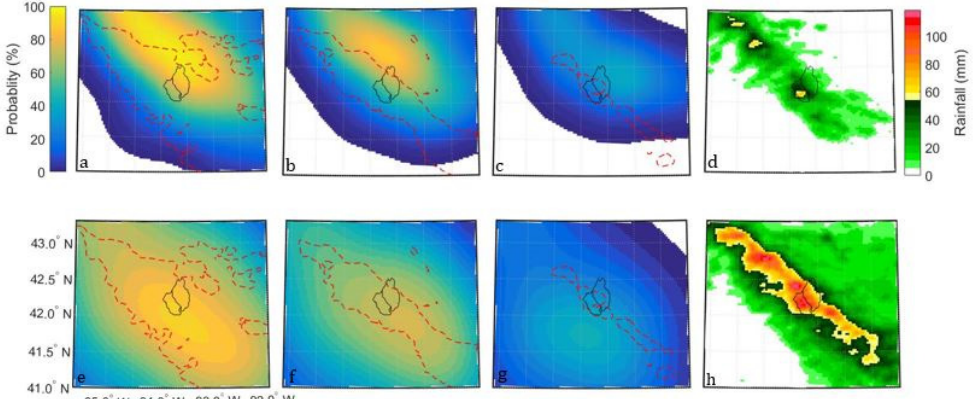
Figure 6. PQPF for the period 12–18 UTC on 14 June from the HRRRE ( a – c ) and HREF ( e – g ) initialized at 00 UTC 14 June, and Stage IV rainfall accumulations (12–18 UTC in d, 00 UTC 14 June–12 UTC 15 June in g) over the central Iowa area. The black outlines represent the basins of the Skunk River (right) and Squaw Creek ( left ). The six panels on the left show PQPF at three different thresholds ( left 12.7 mm, middle 25.4 mm, and right 50.8 mm). The dashed red line represents the Stage IV accumulation exceeding that rainfall threshold.